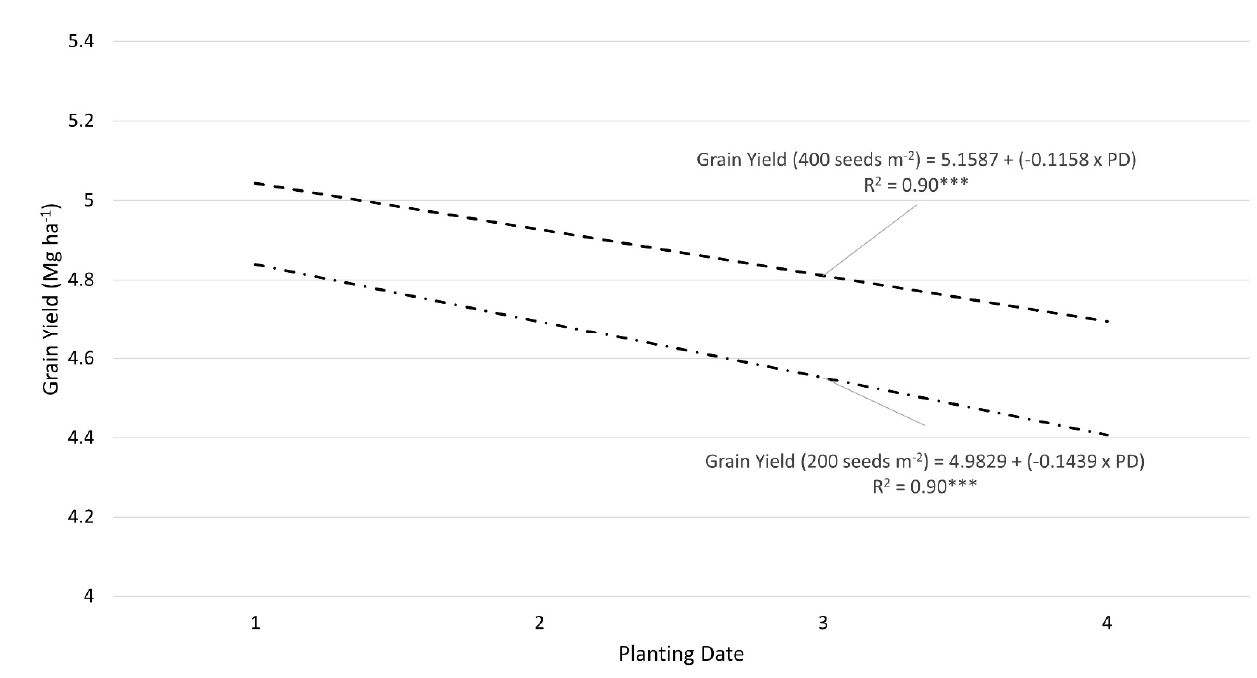
Figure 3. Wheat grain yield as a function of planting date (PD) at 13 environments on the northern Great Plains. PD 1 corresponds to a soil temperature of 0–2.5 °C, with each successive PD equal to a 2.5 °C increase in soil temperature. The lines represent linear regressions for grain yield when planted at 200 seeds m −2 or 400 seeds m −2 . (***) Significant at p < 0.001.